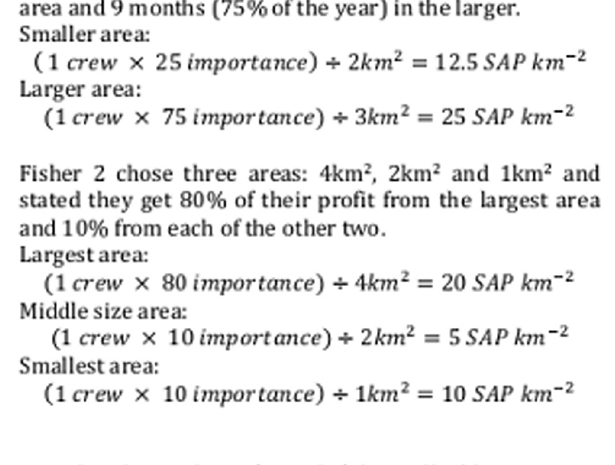
Figure 3. Illustrative example of SAPM with multiple areas and varying importance. Illustrative example of SAPM with multiple areas and varying importance.